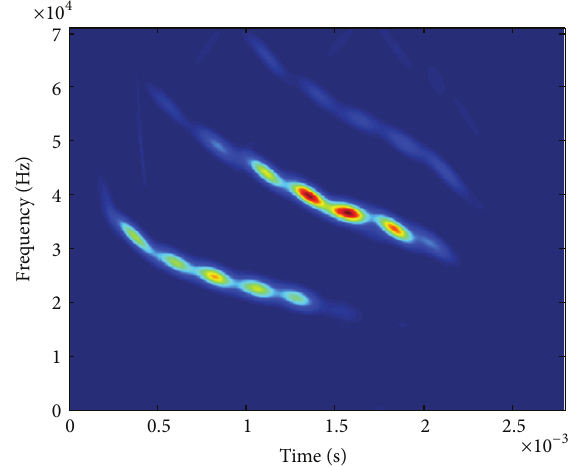
Figure 20: Modified CT spectrogram of Eptesicus fuscus bat echo- location